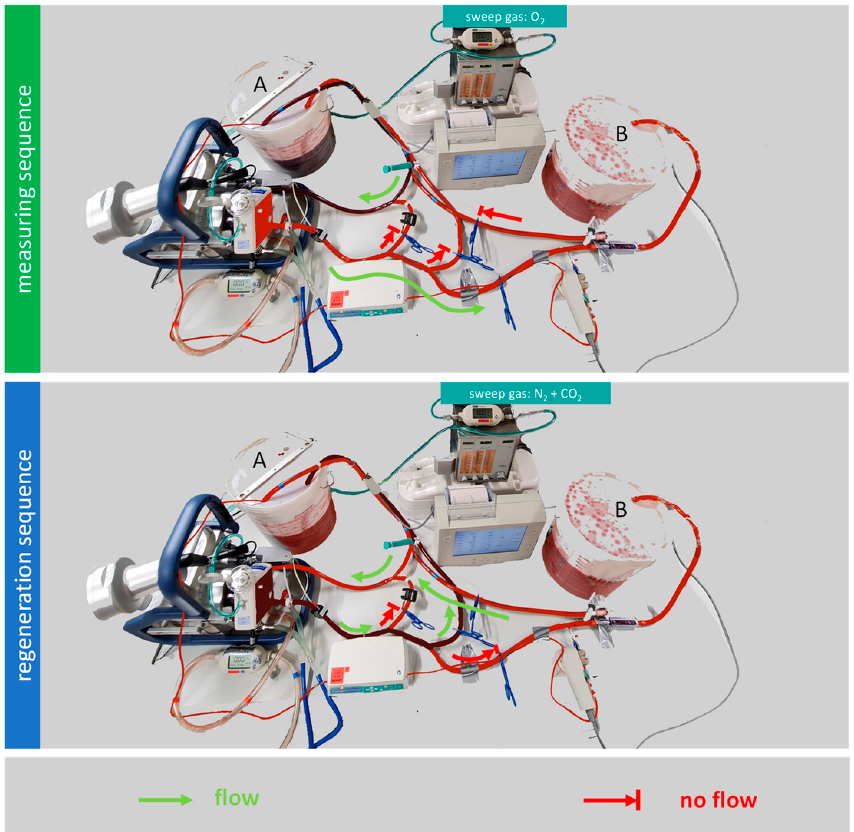
Figure 2. The mock measures discontinuously. During the measuring sequence, the venous blood in bucket A is oxygenated by the membrane lung, and then pumped into bucket B. After the measuring sequence, the arterial blood in bucket B is transferred to bucket A and regenerated to venous blood. During this regeneration sequence, the blood circulates only between bucket A and the membrane lung. In the regeneration sequence, a sweep gas of nitrogen and carbon dioxide is applied to the membrane lung.